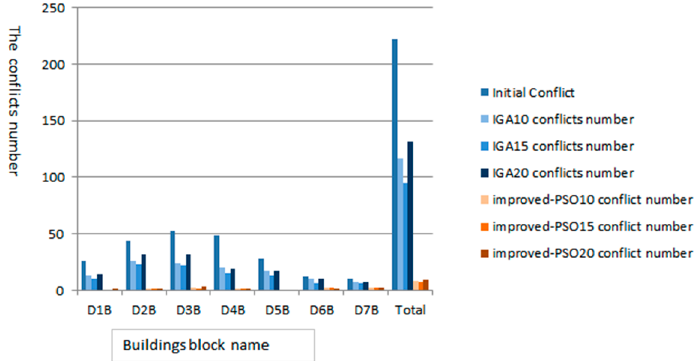
Figure 11. Graphic conflict reduction (unit: meter).